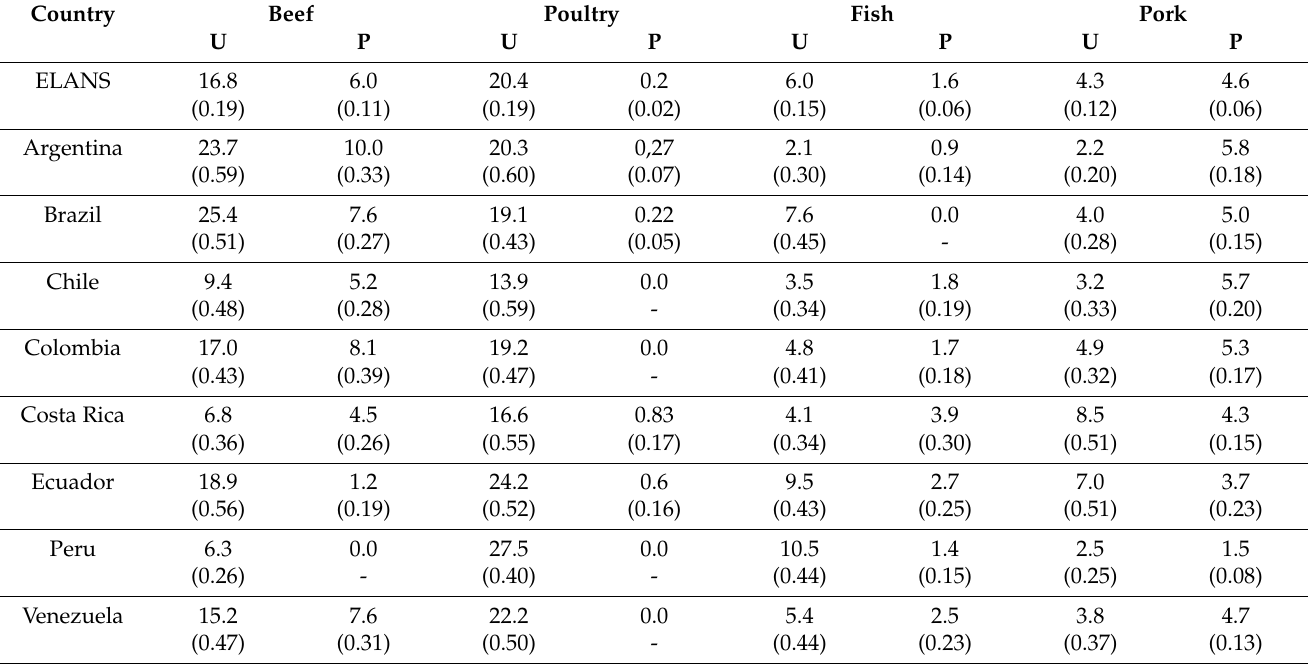
Figure 6. Mean daily plant protein intake (g/day) by food group and ELANS countries. Table 1. Mean daily protein intake (g/day) of processed and unprocessed meats by ELANS